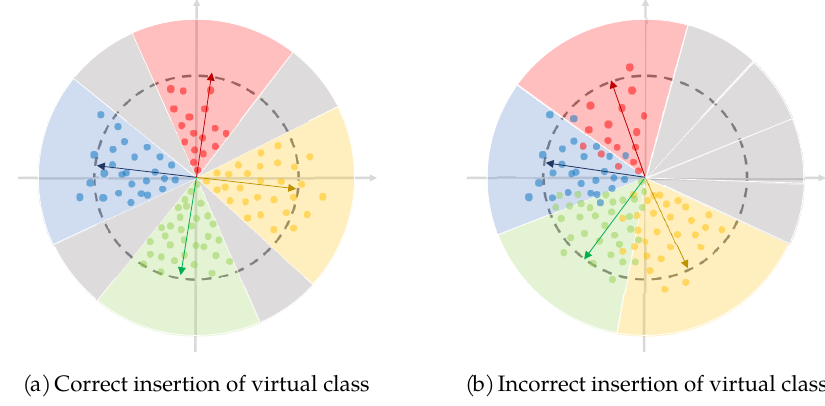
Figure 10. Correct and incorrect insertion of virtual classes.